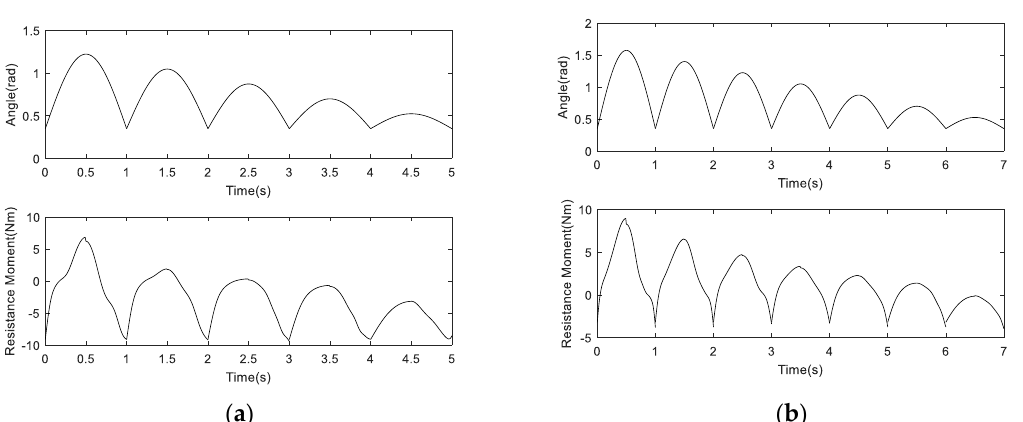
Figure 4. The time–angle (resistance moment) description of first-order transition curves: ( a ) shoulder joint; ( b ) elbow joint.